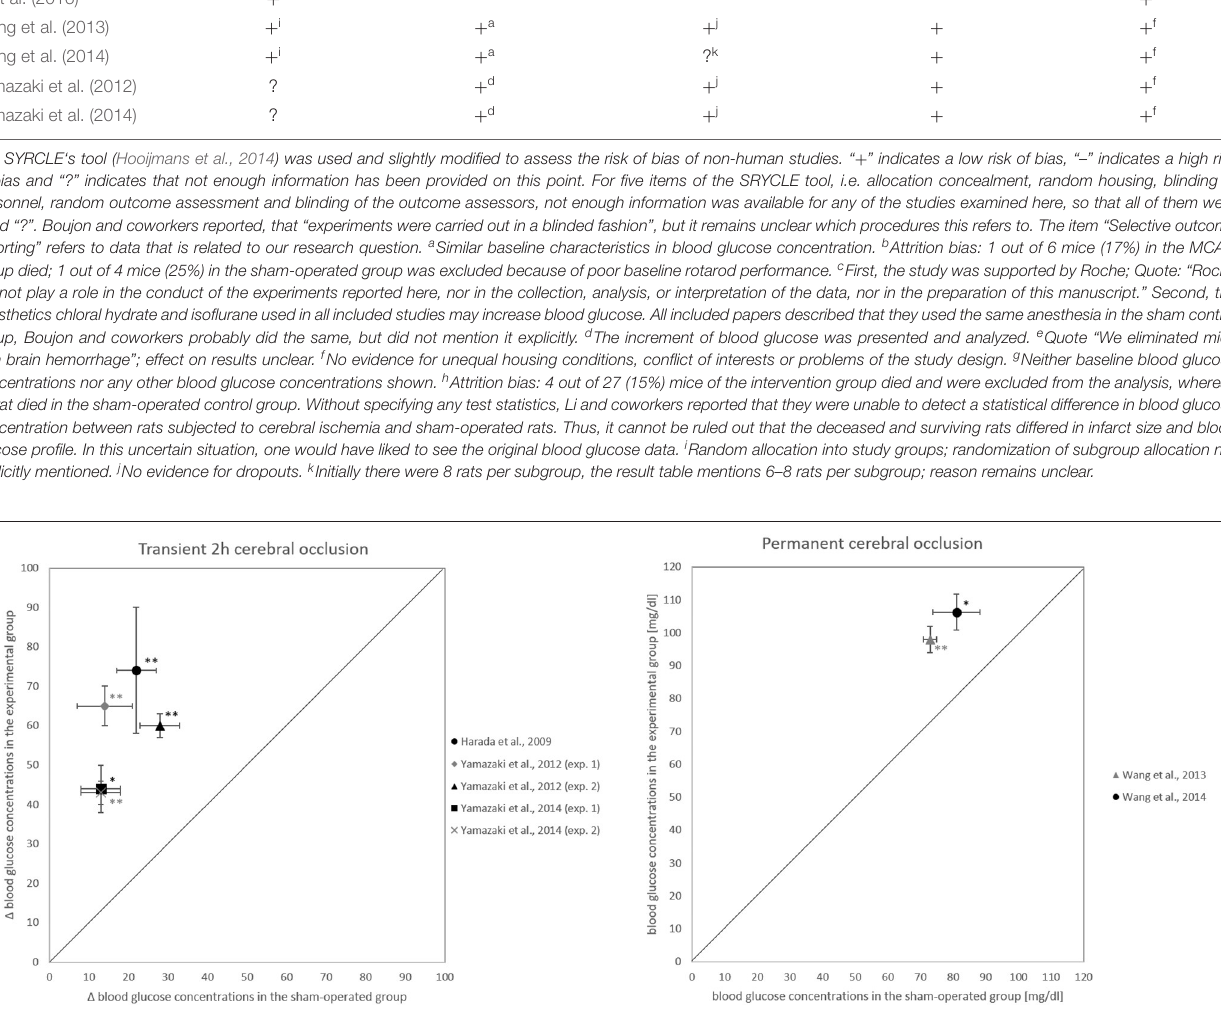
FIGURE 4 | Blood glucose changes 24h after occlusion onset. (Left) Comparison of how experimental and sham-operated groups differ in their blood glucose changes from before to 24h after the onset of transient 2h cerebral artery occlusion. (Right) Comparison of how experimental and sham-operated groups differ